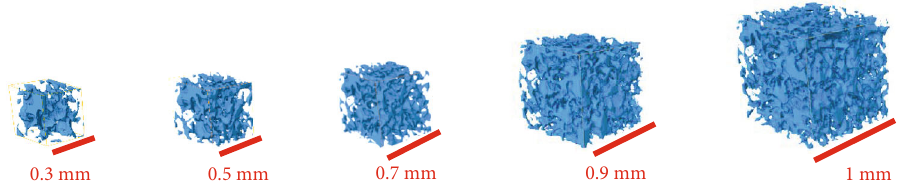
Figure 4: Pore space visualisations of digital Bentheimer subsamples. From left to right: the following subvolumes are shown: ~ 0.04mm 3 ,